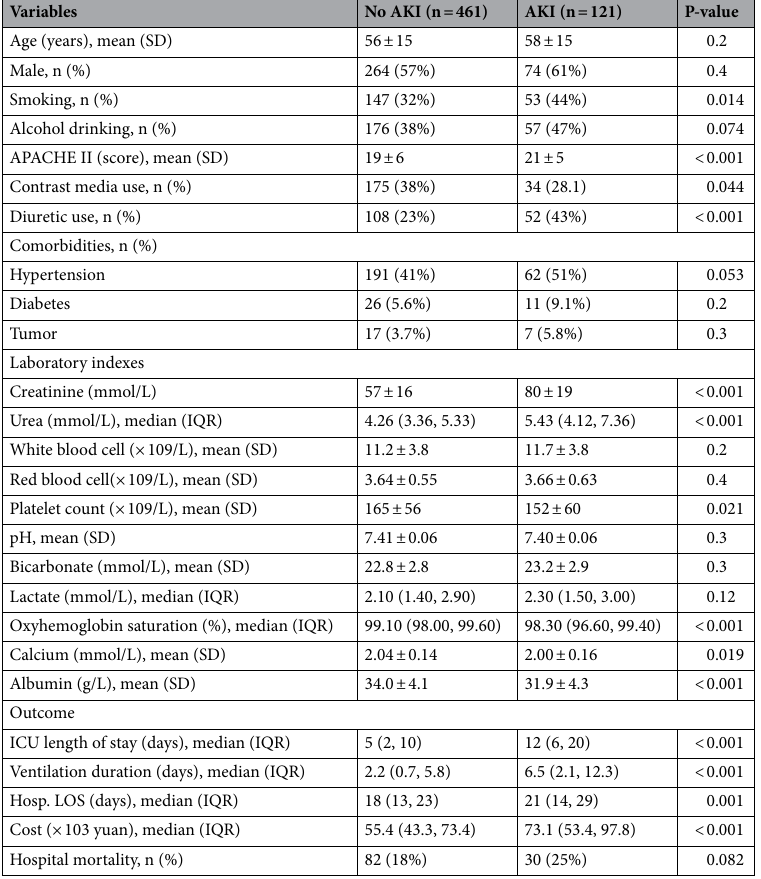
Table 1. Comparisons of baseline characteristics and outcomes between patients with and without AKI. AKI, acute kidney injury; APACHE, Acute Physiology and Chronic Health Evaluation; ICU, intensive care unit; Hosp. LOS, length of hospital